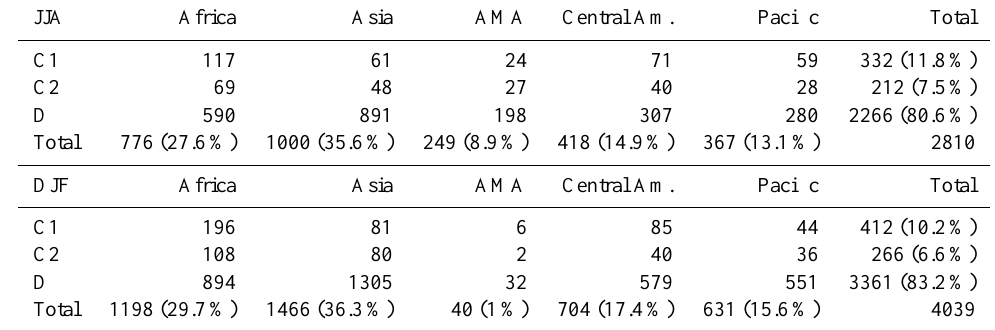
Table 2. Number of SVC according to their temperature history coherence in DJF and JJA (from 2006 to 2008) over 15 days back-trajectories. JJA